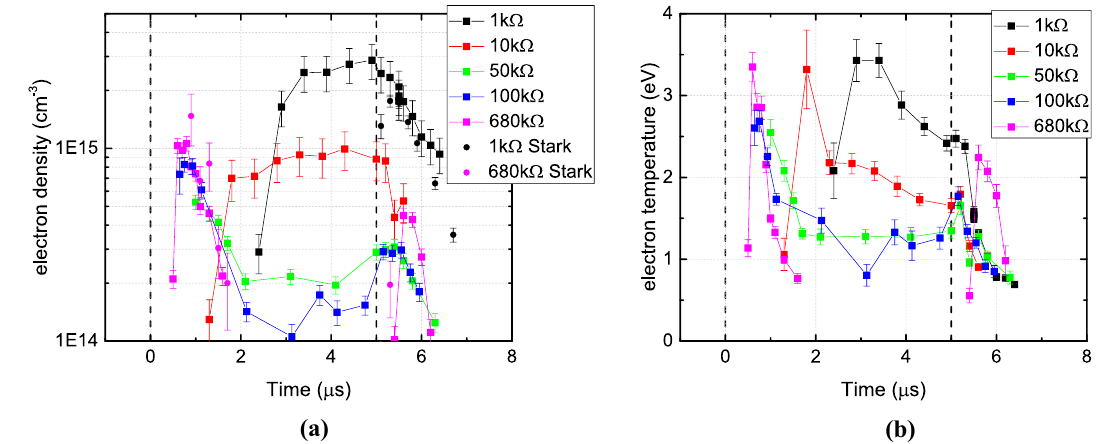
Figure 3. The obtained electron density ( a ) and temperature ( b ) for all five cases of increasing resistance during and after the applied 5 µ s high voltage pulses. For high electron densities (e.g. above 6 exposures were taken at each data point and 6000 exposures for lower electron